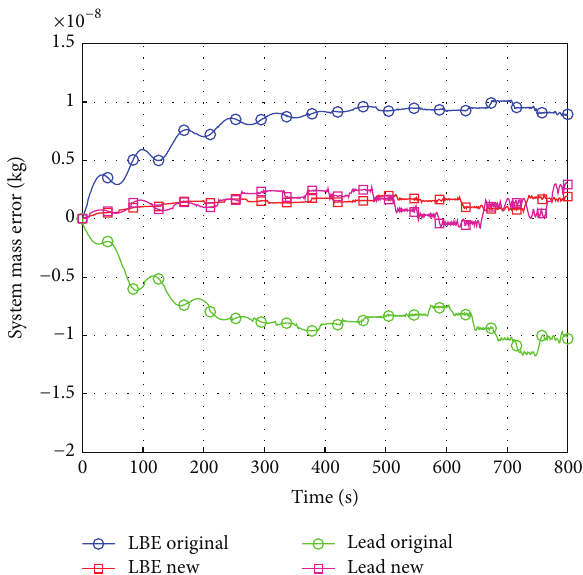
Figure 22: System mass error, LBE and Lead original versus new properties.